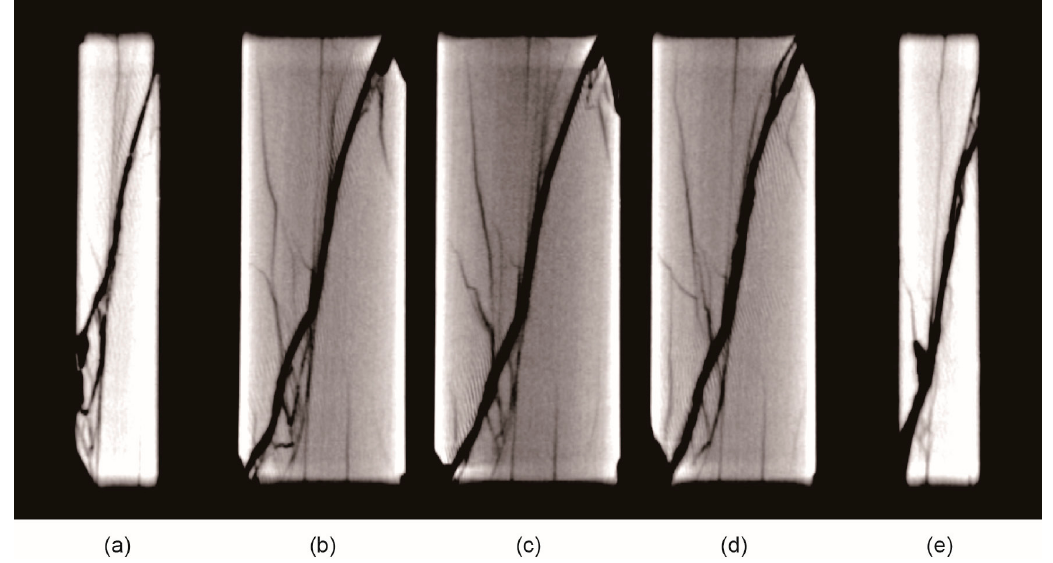
Figure 8. CT scanning slices of the sample along the axial direction and normal to the bedding plane. The labels ( a – e ) indicate the position of selected slices from x = − 22.5 mm to x = 22.5 mm with 11 mm intervals.